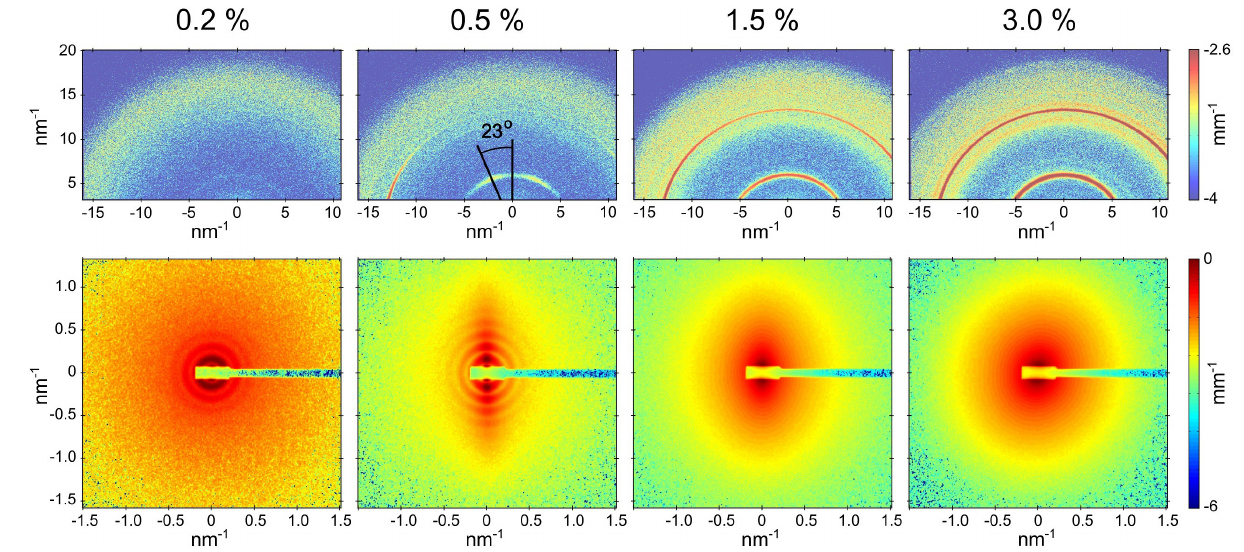
FIGURE 1 | Partially aligned SAXS and WAXS patterns (lower and upper panels, respectively) from A β (16-22) peptide samples at four different concentrations after the solvent background subtraction. In the case of 0.5 % sample, the nanotubes are aligned along the horizontal axis and the relative orientation of nanotube radius and β -sheet laminations is shown. The SAXS sample-detector distance was